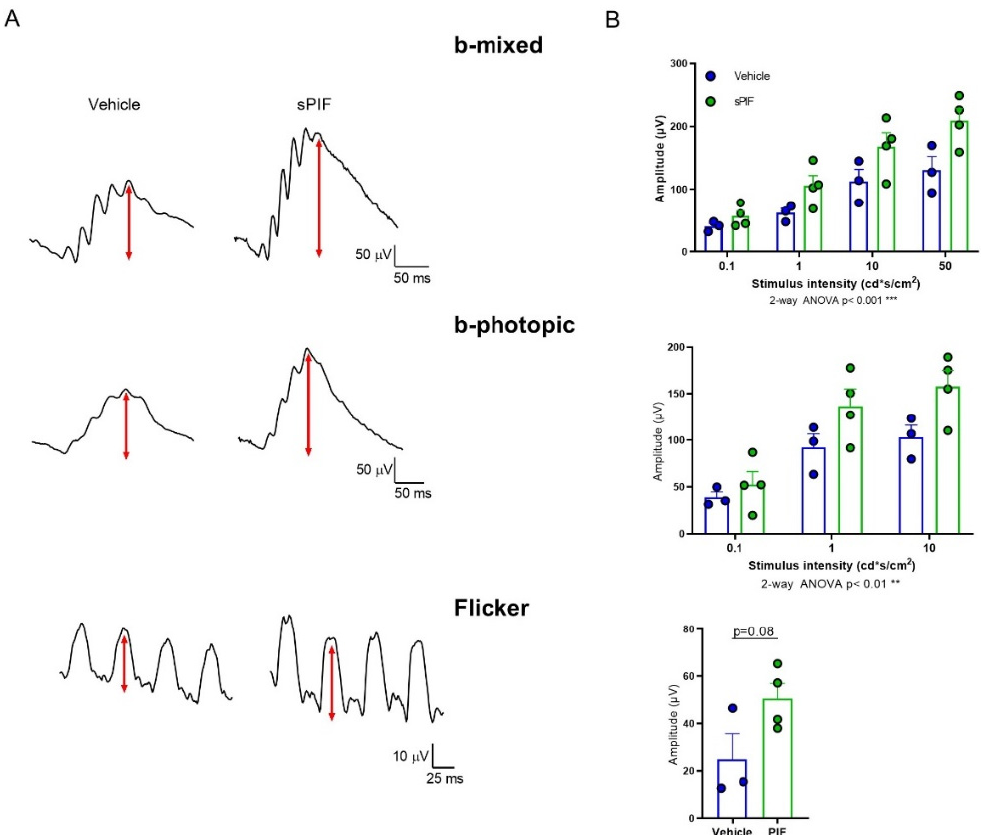
Figure 5. Effect of sPIF treatment on retinal response to light in rd10 mice. Animals received daily intraperitoneal injections of vehicle or sPIF from P15 to P27. ERG recordings were performed at P28. ( A ) Representative ERG responses of vehicle- and sPIF-treated mice to a stimulus of 50 cd·s/m 2 . Scale bar value is indicated in the figure. ( B ) Graphs show mean ERG wave amplitudes, plotted as a function of light stimulus. Amplitudes of rod and cone mixed responses (b-mixed waves) to the indicated light intensities were recorded under scotopic conditions after overnight adaptation to darkness. Amplitudes of cone responses (b-photopic and flicker waves) to the indicated light intensities were recorded under photopic conditions after 5 min of light adaptation (30 cd·s/m 2 ). Dots represent individual mice, and bars represent the mean (+SEM) for each group. n = 3–4 animals per group. *** p < 0.001; ** p < 0.01 (2-way ANOVA); p = 0.08 (unpaired 2-tailed Student’s t -test).